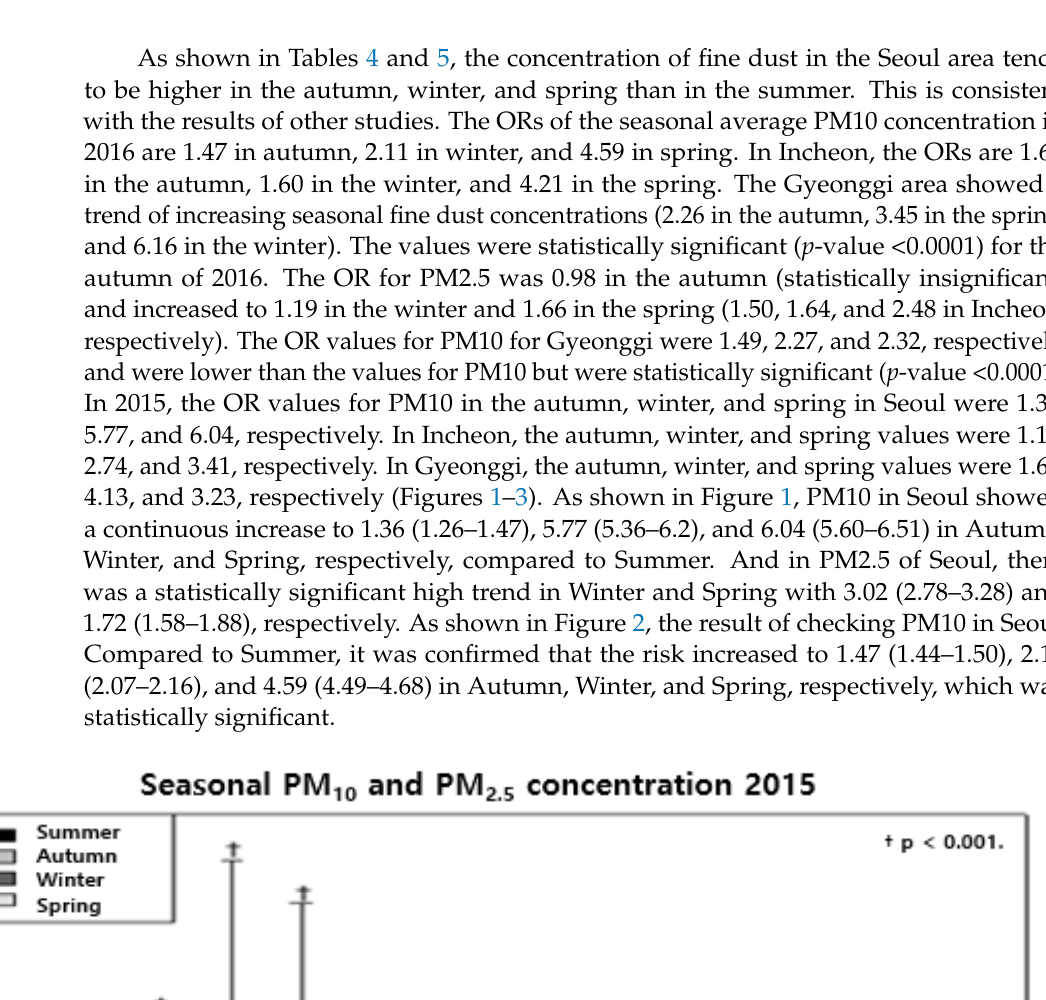
Figure 2. Correlation between the concentration (log-linear) of seasonal fine dust (PM10) and the Seoul area (2016). Figure 3. Correlation between the concentration (log-linear) of seasonal fine dust (PM2.5) and the Seoul area (2016).